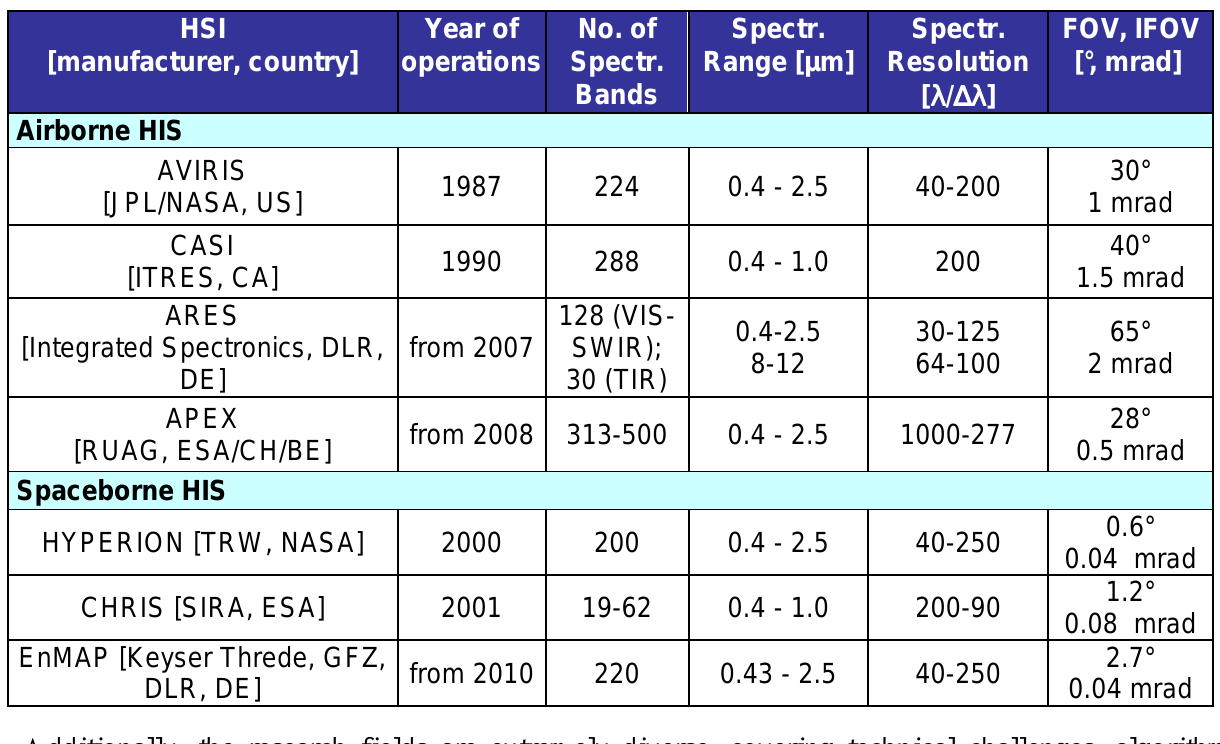
Table 1. Specifications and key design parameters for current and future HSI instruments and